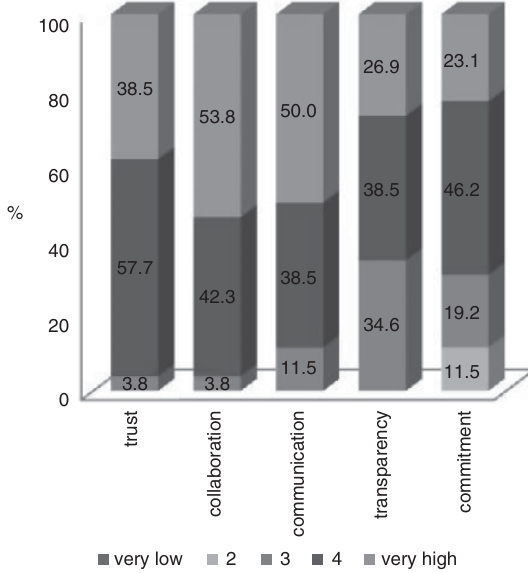
Fig. 7. Current level of mutual